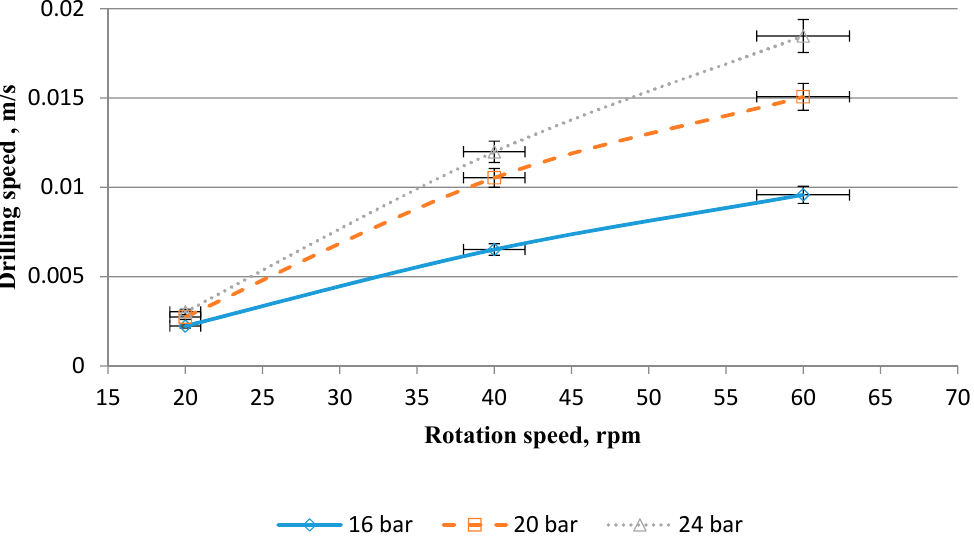
Figure 6. Variation of drilling velocity with rotation speed for several pressures (shown in the legend below the figure), for the 110 mm diameter drill bit, an interval of 72 to 90 m below the ground level, and boreholes 1–3.